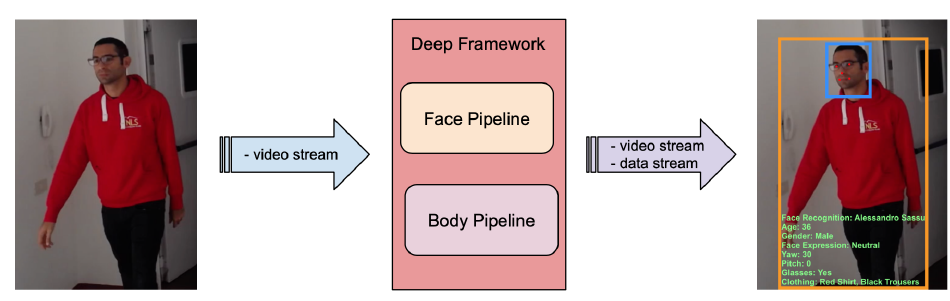
Figure 10. Example of a customer intelligence application designed with